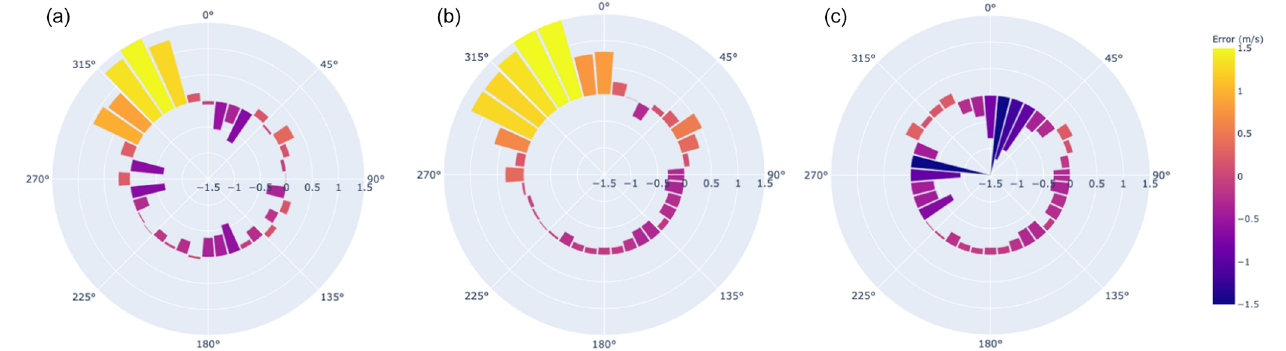
Figure 9. Average error in ms − 1 for IEC site grouped by wind speed direction (10 ◦ sectors) for (a) LANL/QUIC, (b) KNW-Atlas reanalysis, and (c) ANL non-linear. Positive errors (lighter colours) suggest an overestimate of the wind resource relative to observed data, whereas negative errors (darker colours) indicate the opposite. The scale of errors for each plot is given on the radial